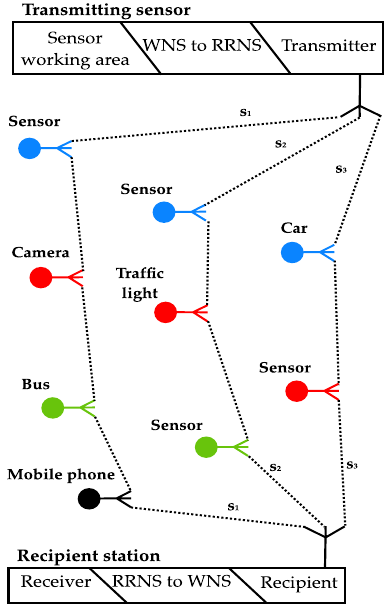
Figure 2. Distributed data transmission model.